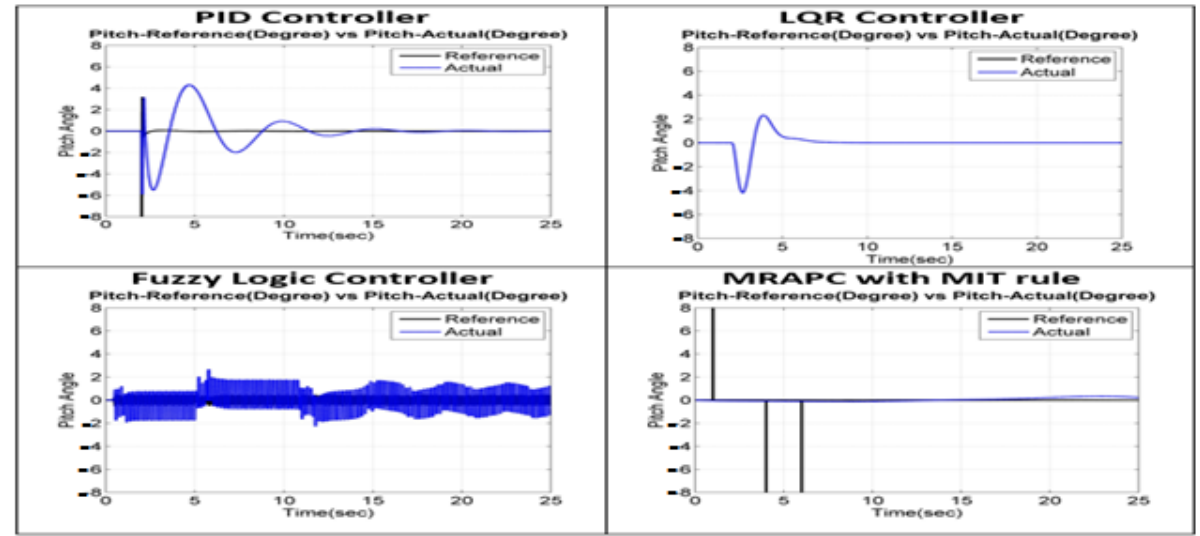
Figure 16. Roll ( ϕ ) Control result depending on step input for all control systems.